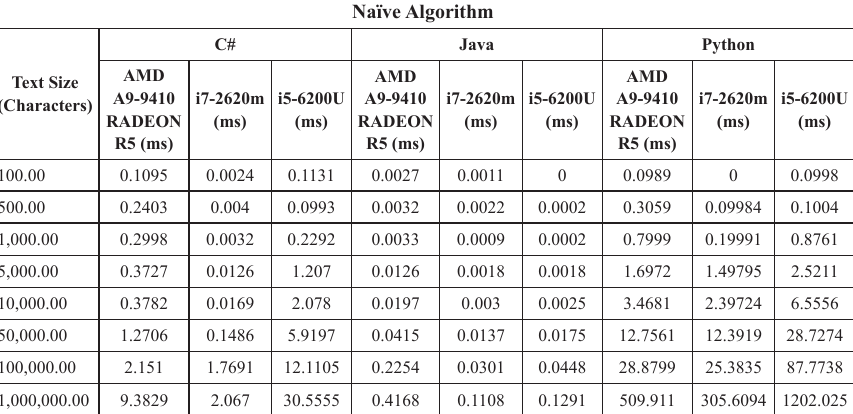
Table 1. Running time of Naive algorithm in C#, Java and Python programming languages Naïve Algorithm